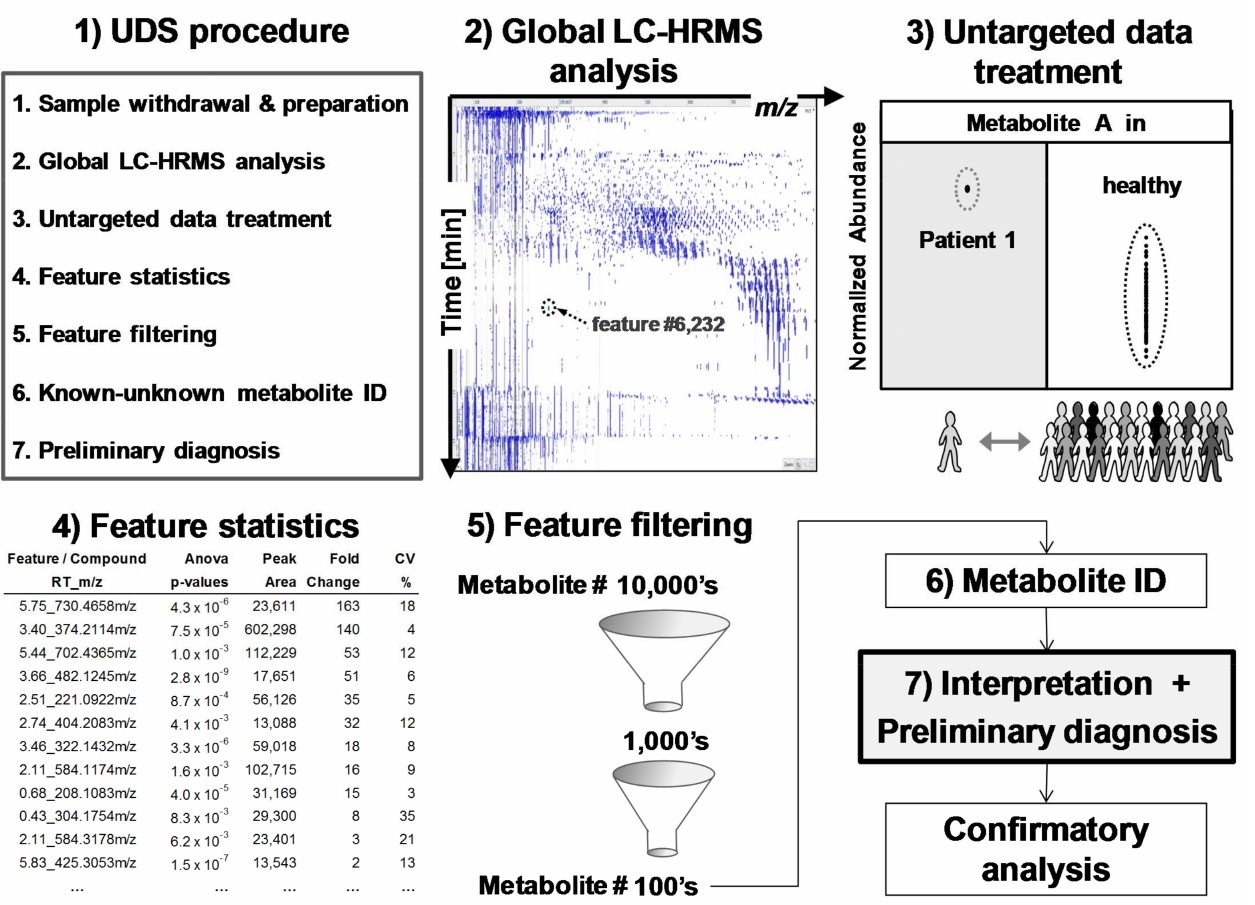
Figure 3. Untargeted diagnostic screening (UDS): ( 1 ) Overview of UDS prototole ( 2 ) serum extracts are analyzed by global LC-HRMS acquisition; ( 3 ) data treatment reveals and ranks, via ( 4 ) feature statistics, compounds of interest in a sick patient (test sample) in comparison to healthy population (control samples); features are ( 5 ) filtered and ( 6 ) identified for ( 7 ) biomedical interpretation and preliminary diagnosis prior confirmatory, targeted, and quantitative analyses. A feature is an ion-retention time entity that corresponds roughly to a